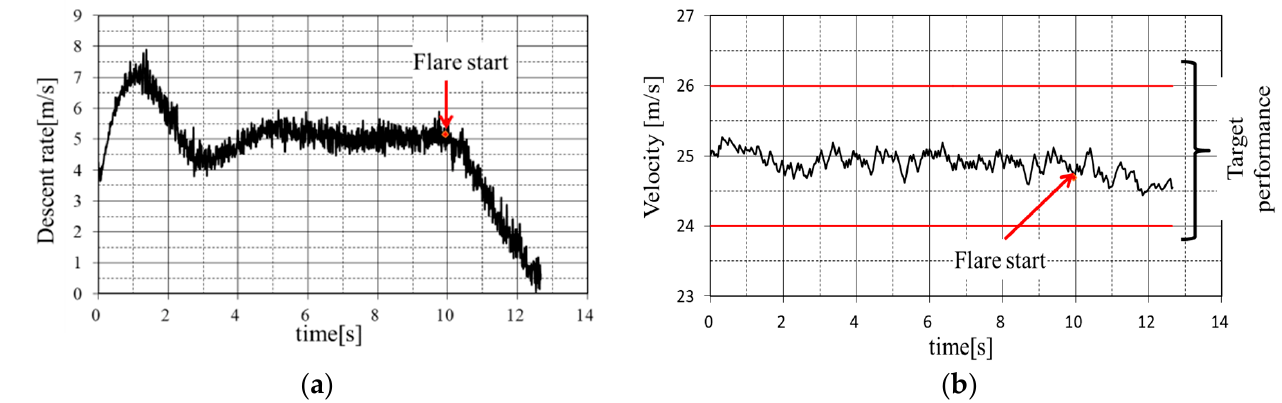
Figure 10. ( a ) Descent-rate profile; ( b ) velocity profile.